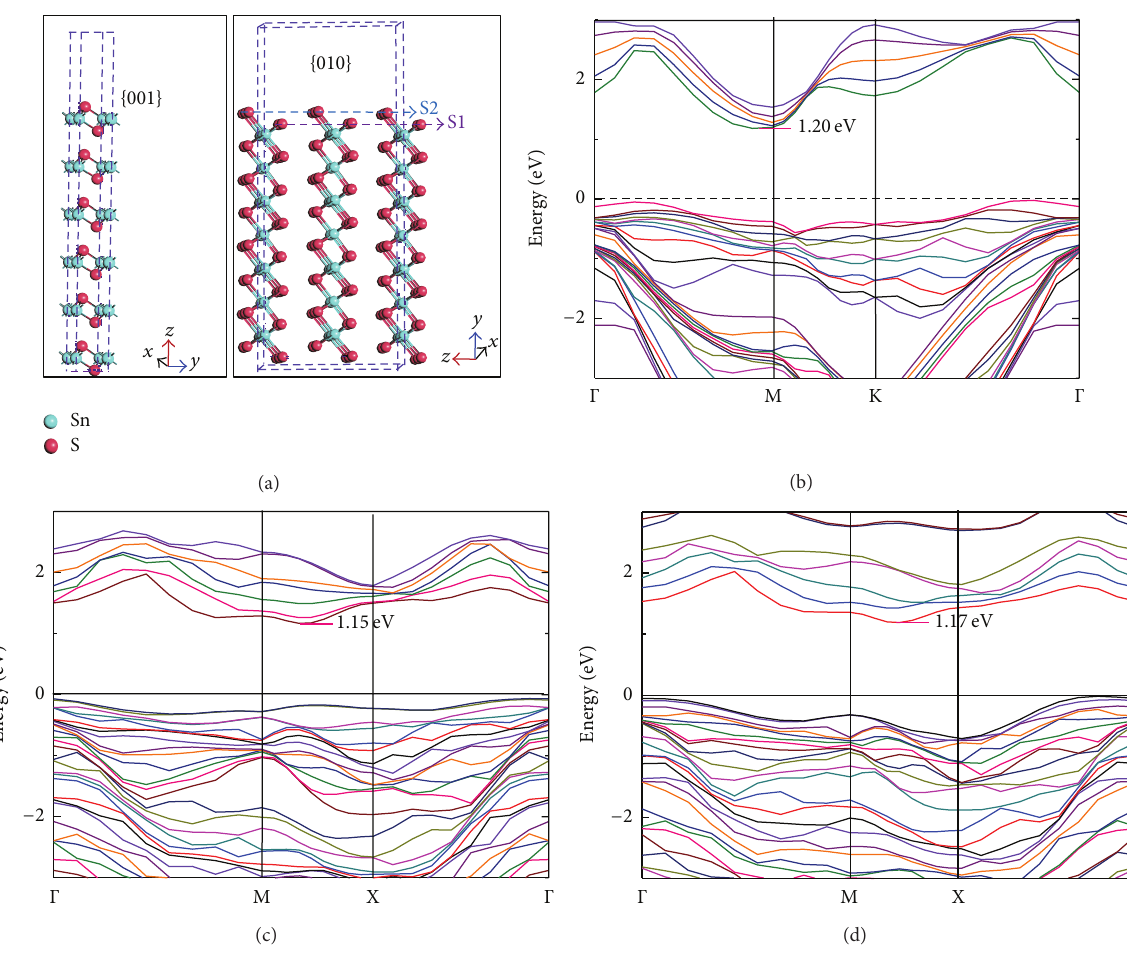
Figure 7: (a) Slab models of SnS 2 {001} and {010} surfaces; ((b)–(d)) electronic structures of S001, S 010